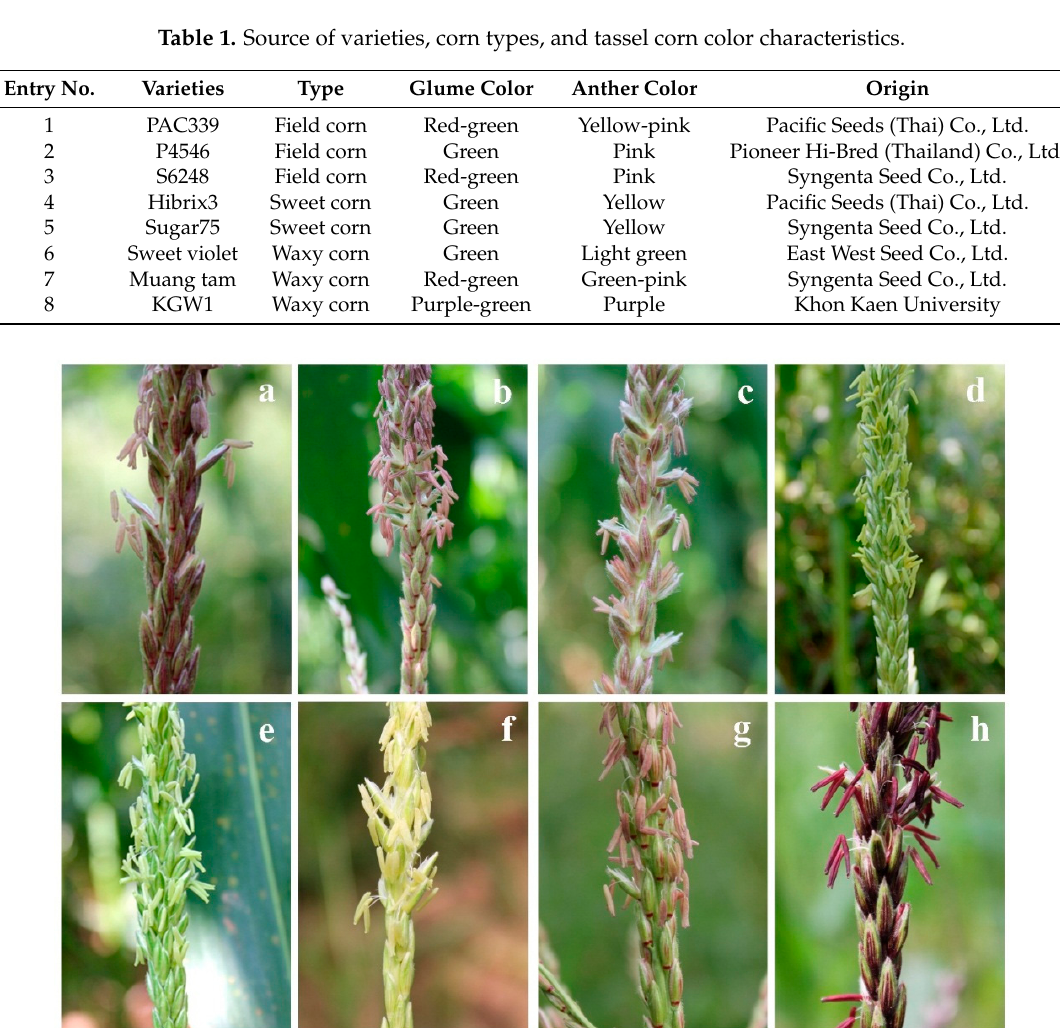
Figure 1. Close-up photographs of the main spike of the tassel of eight commercial hybrids: PAC339 ( a ),